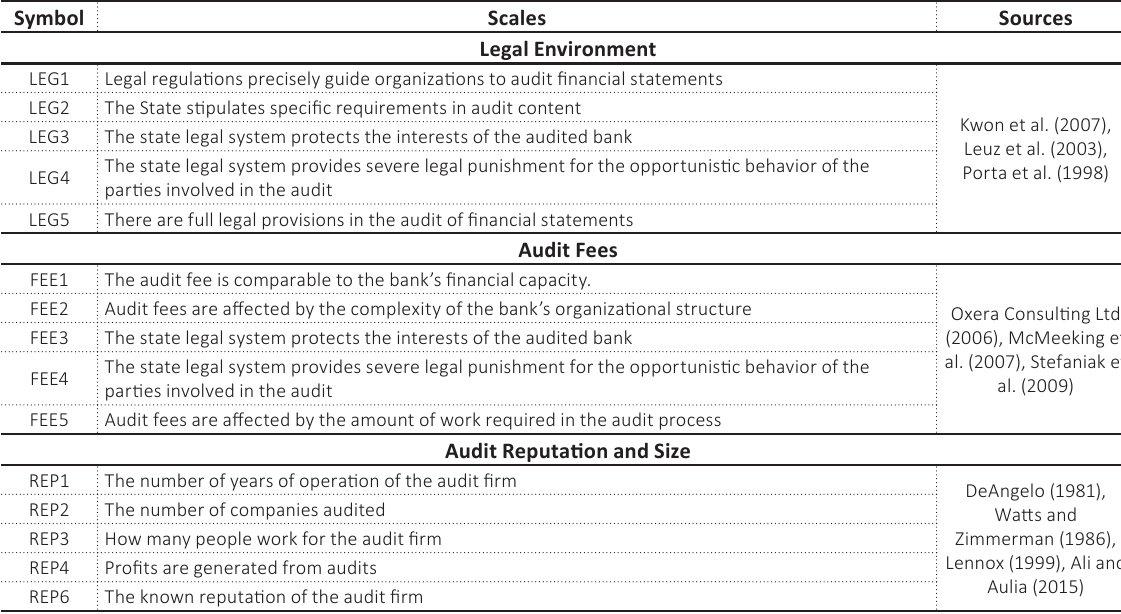
Table 2. Dimensions and scales